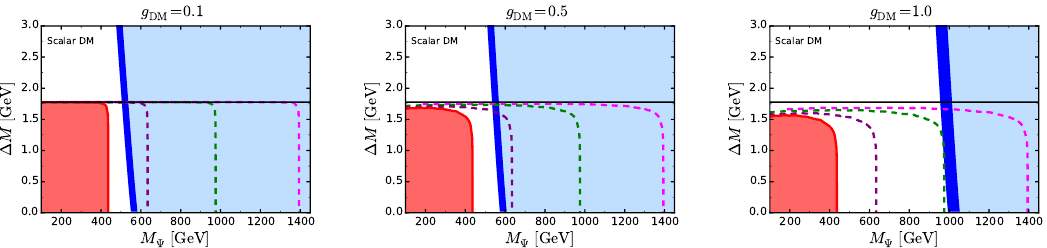
Figure 10 . Model 2: the co-annihilation strip and collider searches for scalar DM and a long-lived charged Dirac fermion (cid:9). The dark-blue region satis(cid:12)es the correct dark matter relic abundance within 3 (cid:27) , the light-blue region overproduces the dark matter energy density. The horizontal black line corresponds to the mass of the (cid:28) lepton. The region coloured in red corresponds to current HSCP limits for center-of-mass energy of 8 TeV and 18.8 fb (cid:0) 1 . The three dashed lines (purple, green and magenta) correspond to our projections for center-of-mass energy of 13 TeV and 30, 300 and 3000 fb (cid:0) 1 of integrated luminosity